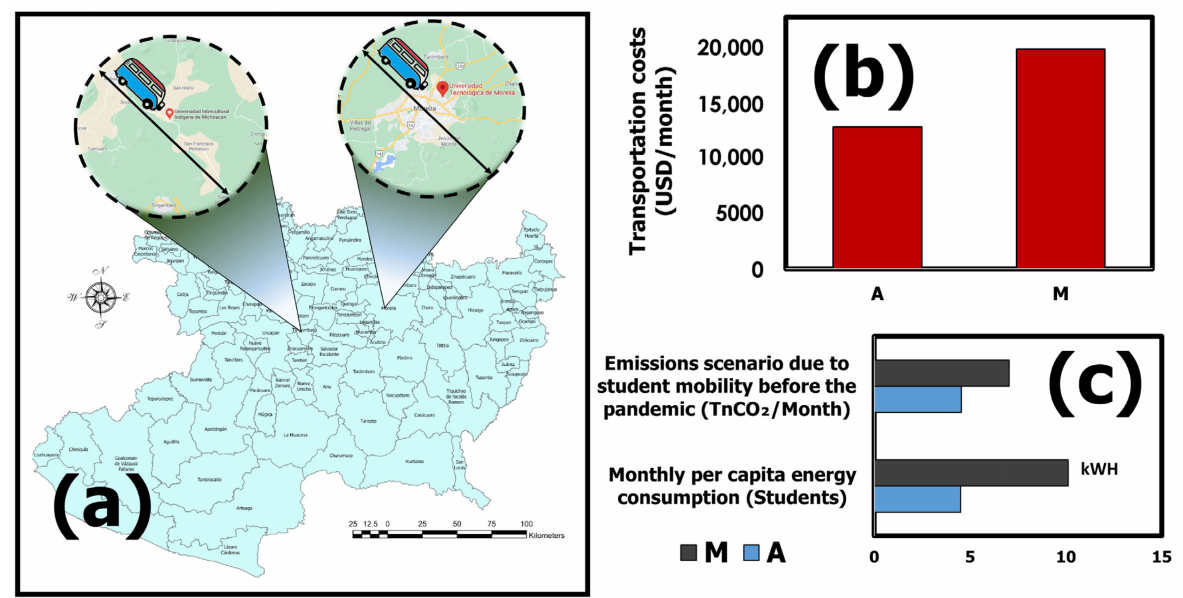
Figure 8. Student mobility reduction scenario: ( a ) Geographical location of 2 analysis cases i = UTM, ii = UIIM ( b ) Monthly transportation costs for UTM and UIIM student enrollment ( c ) Comparative analysis of energy consumption and emissions generation UTM and UIIM.